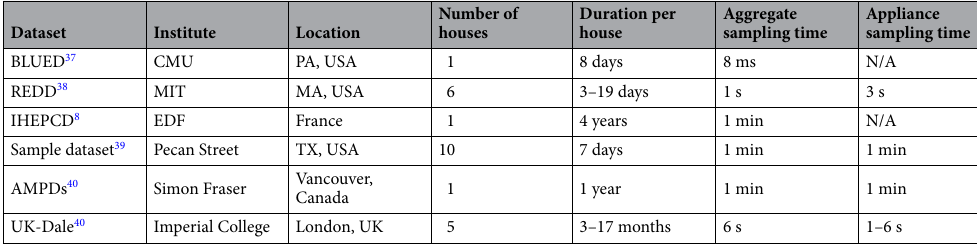
Table 2. Publicly available dataset for